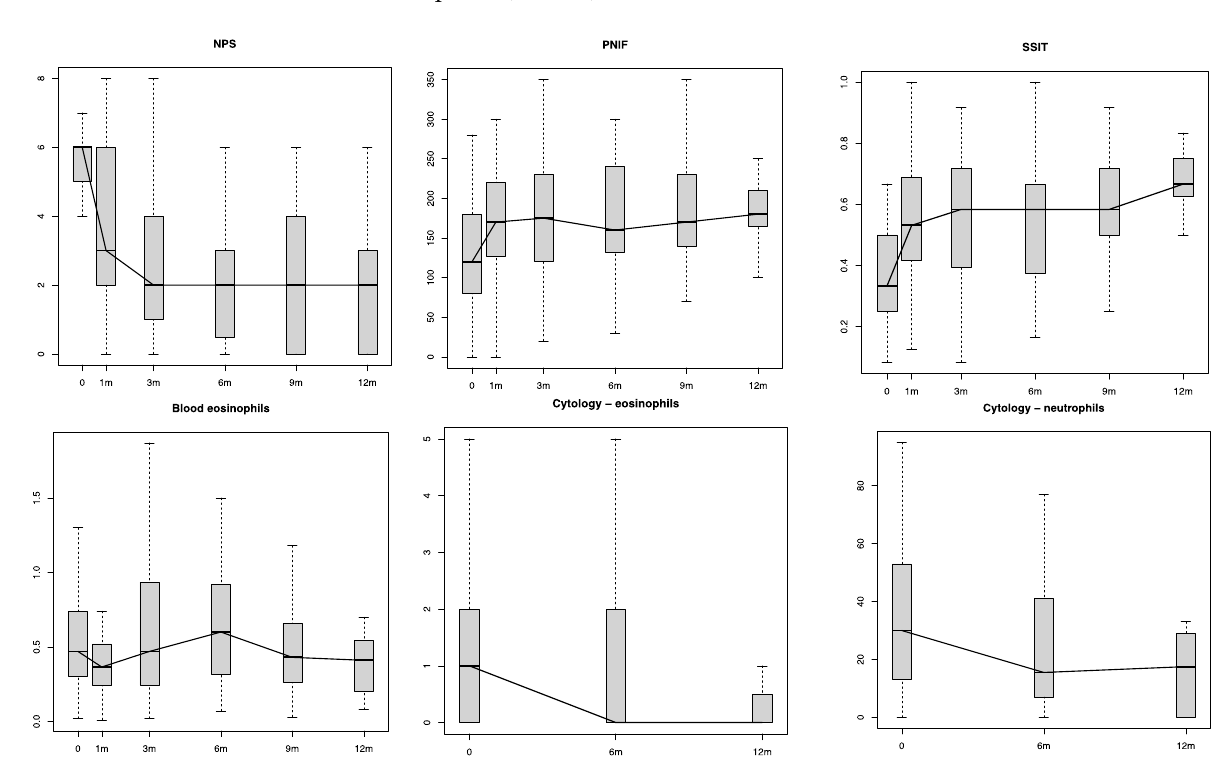
Figure 1. Patient-Reported Outcome measures (PROMs) changes during the study period. SNOT- 22: Sinonasal Outcome Test-22; VAS-NO: Visual Analogue Scale for Nasal Obstruction; VAS-smell: Visual Analogue Scale for smell; NCS: Nasal Congestion Score; ACT: Asthma Control Test; m: months.